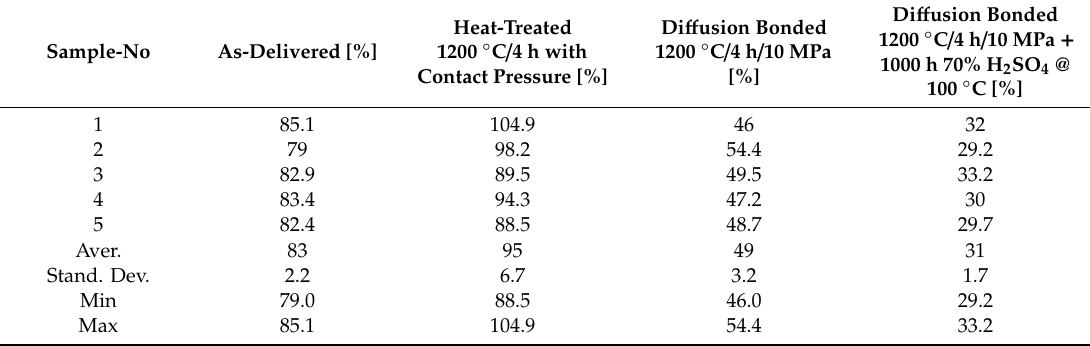
( B ) Elongation at fracture, (continued).